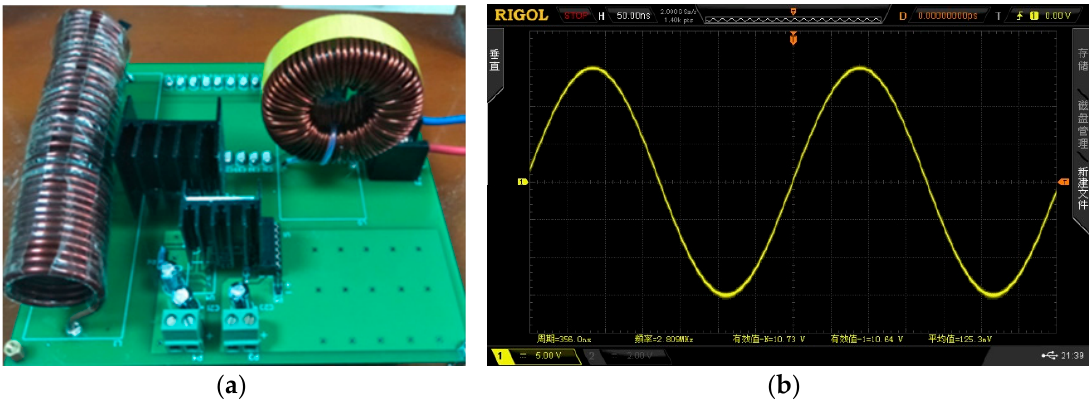
Figure 10. ( a ) The physical circuit board of each component of the Class ‐ E amplifier. ( b ) The voltage waveform of the test load resistance.